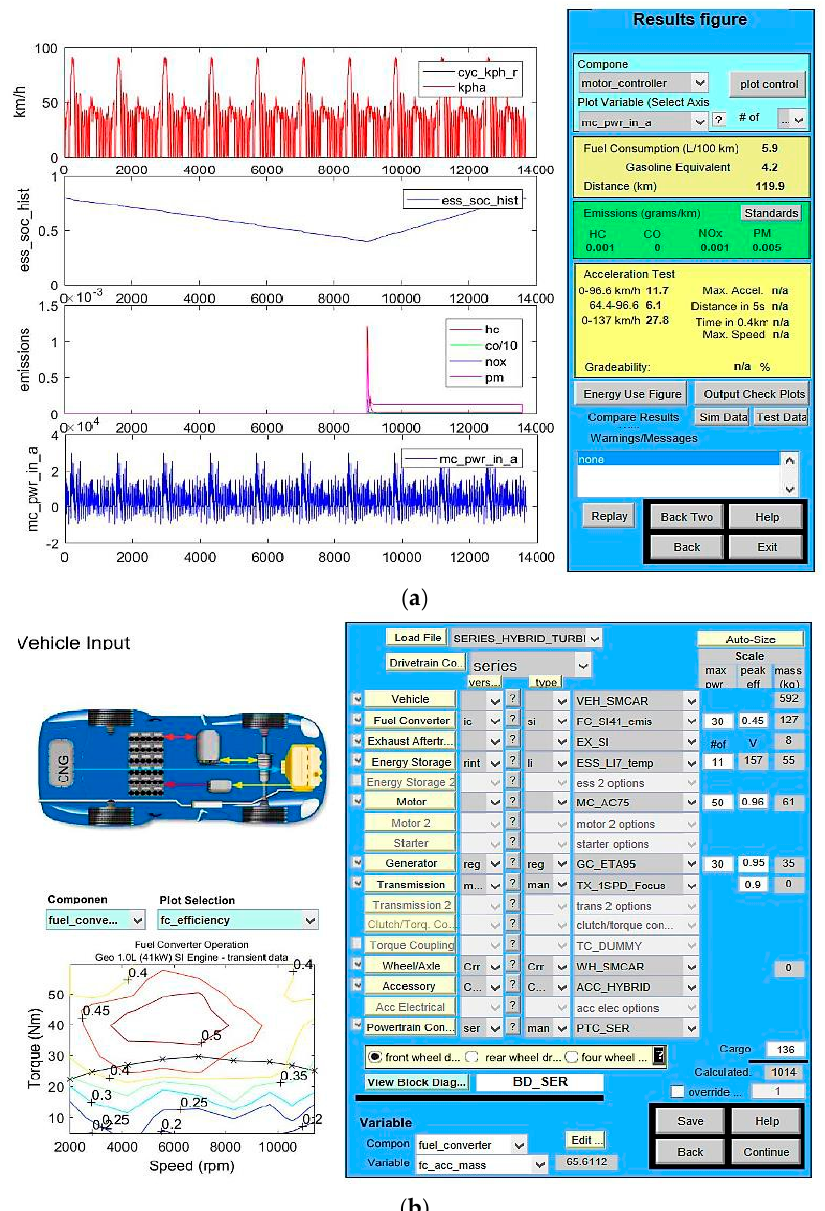
Figure 13. Example of Simulation Results Using Advisor. ( a ) simulations results; ( b ) vehicle input data.